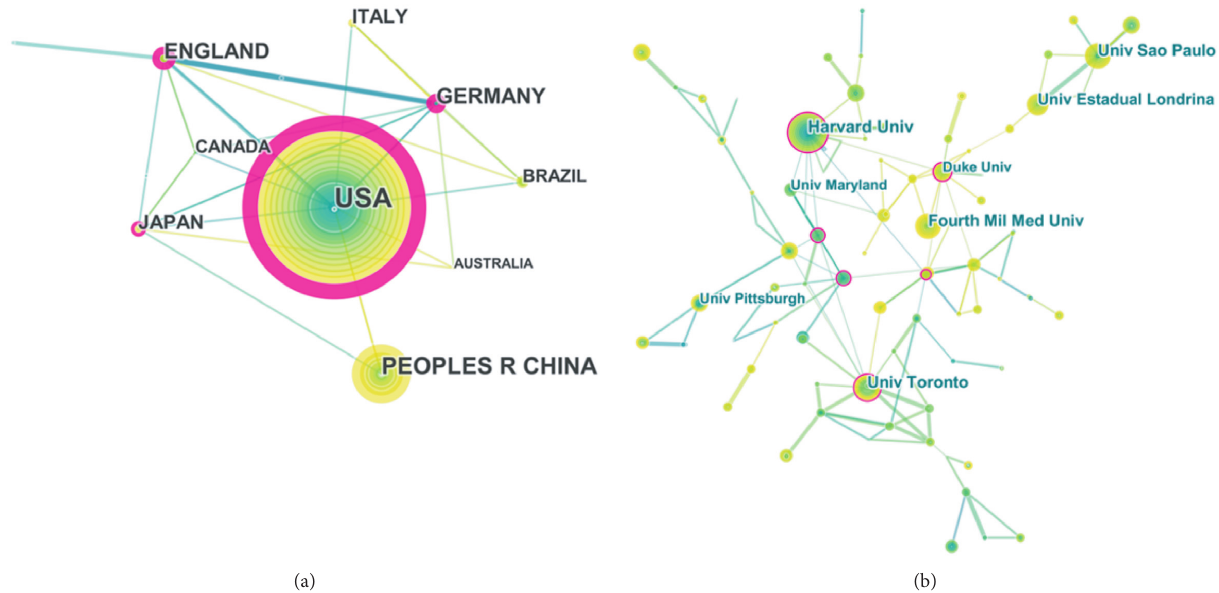
Figure 7: The analysis of countries and institutions. (a) Network map of countries/territories engaged in pain and inflammation research. (b) Network map of institutions engaged in pain and inflammation